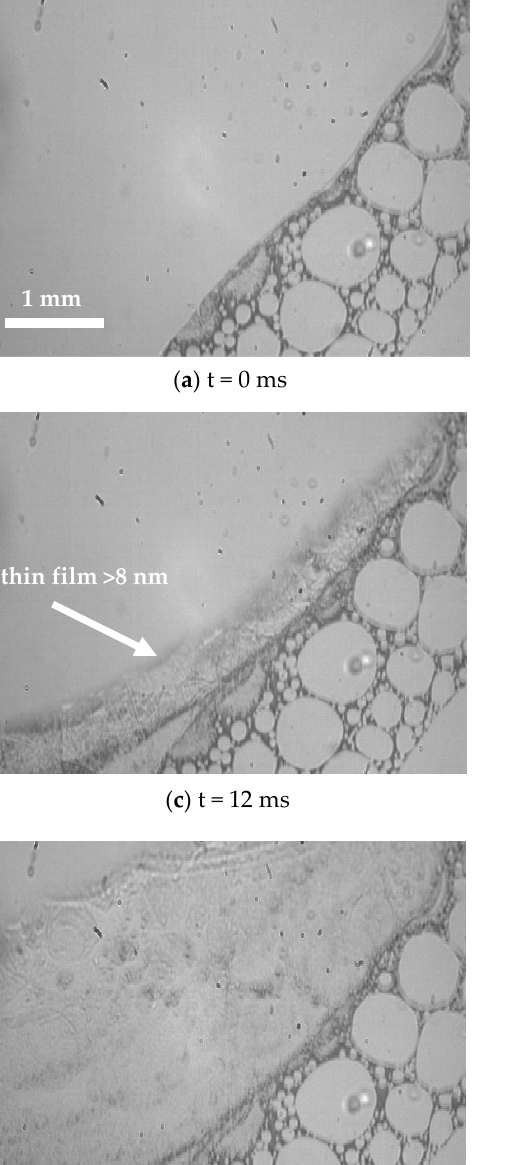
Figure 7. ( a ) Theoretical correlation between the reflectance and thickness of the water film, as visualized using SPRi at an experimental angle of 43.15 degrees and a wavelength of 680 nm, ( b ) a raw image of a thin film between droplets during USDC (bright and dark grays represent thin films and droplets, respectively), and ( c ) the corresponding processed image of thin films grown between droplets during USDC (dark blue, light blue, and yellow colors represent droplets, film with thickness smaller than 8 nm, and film with thickness larger than 8 nm, respectively).